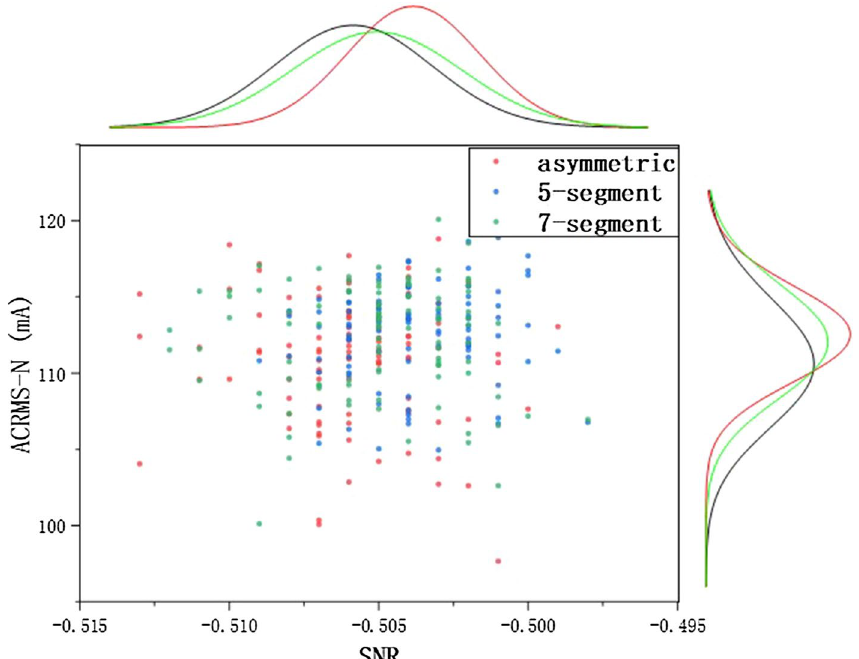
Figure 15. The marginal histograms.